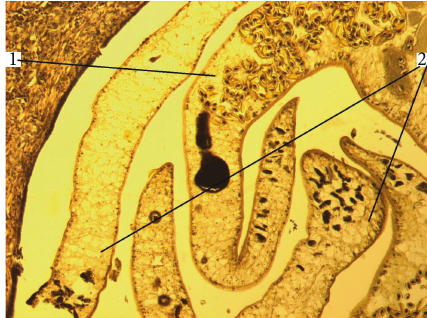
Figure 4: Clumps of opisthorchii in cholangiectasis in liver cancer in the setting of SO. HE staining, magni fi cation 100x (1: mature parasites; 2: immature parasites).